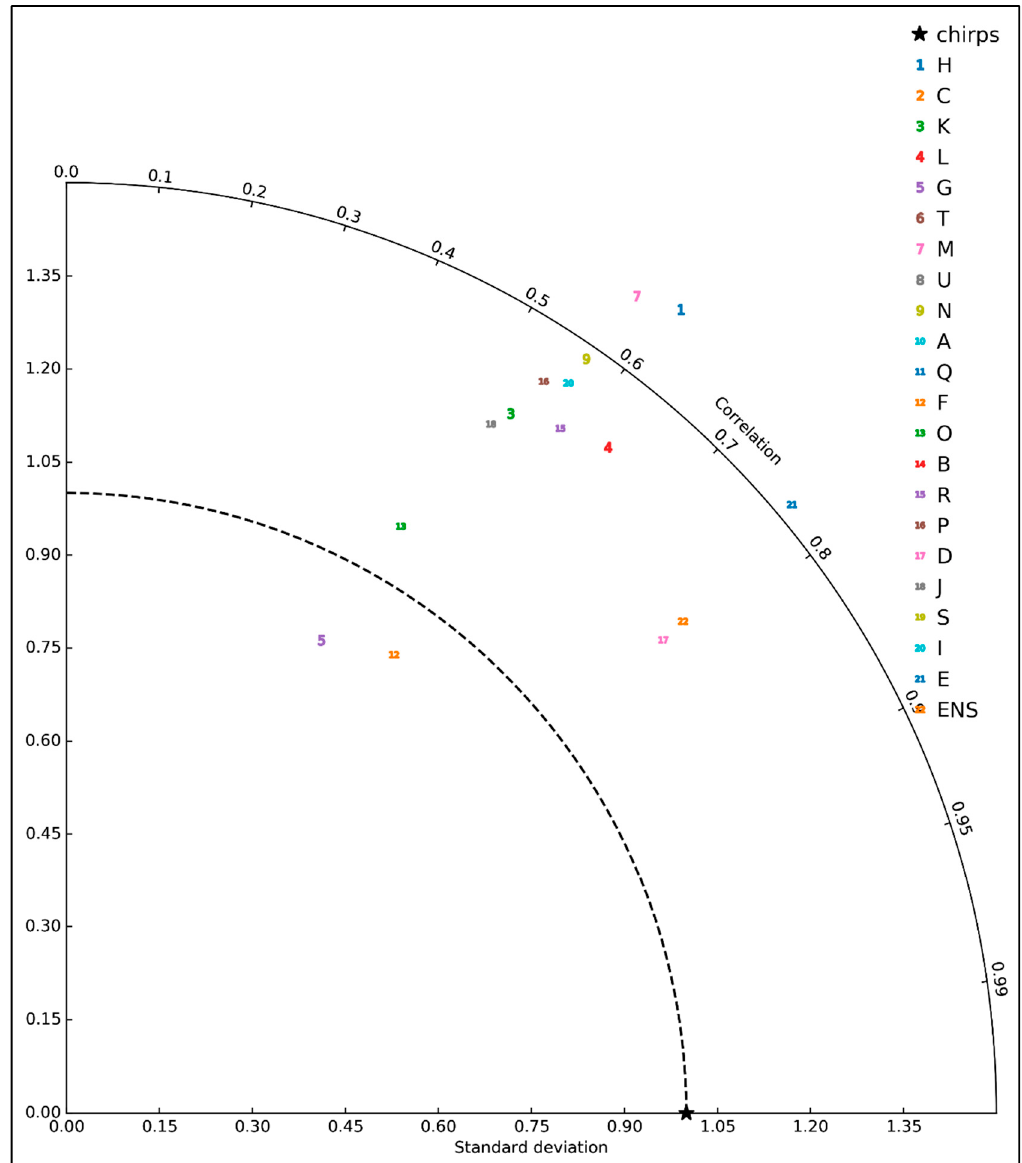
Figure 9 . Taylor diagram analysis of monthly rainfall averaged over Kenya domain during the period 1981–2005, from CHIRPS and the 21 Coordinated Regional Climate Downscaling Experiment (CORDEX) models listed in Table 2 .